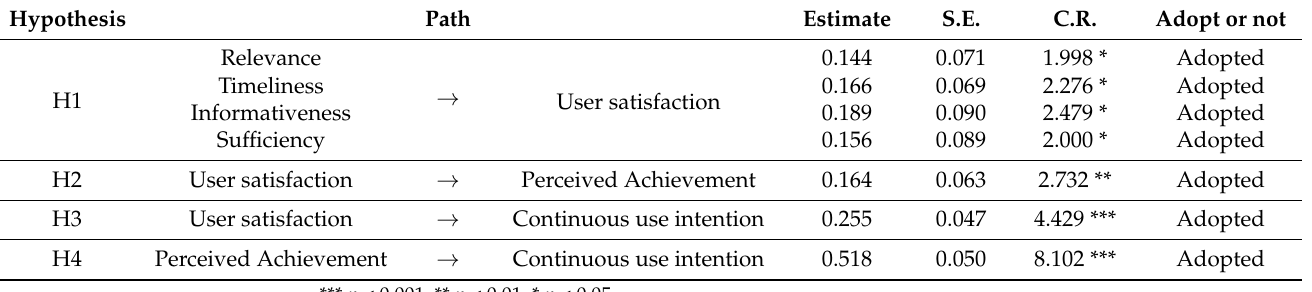
Table 5. Hypothesis test results.